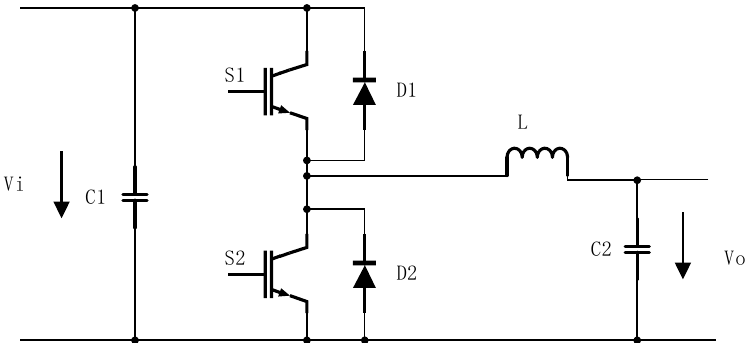
Figure 2. Non-isolated bidirectional half-bridge buck-boost converter. The operation mode of the bidirectional half-bridge buck–boost converter includes the buck mode and the boost mode. When the power of the DC bus is greater than the energy storage system, the converter works in buck mode. The theoretical waveform of the inductor current i L is shown in Figure